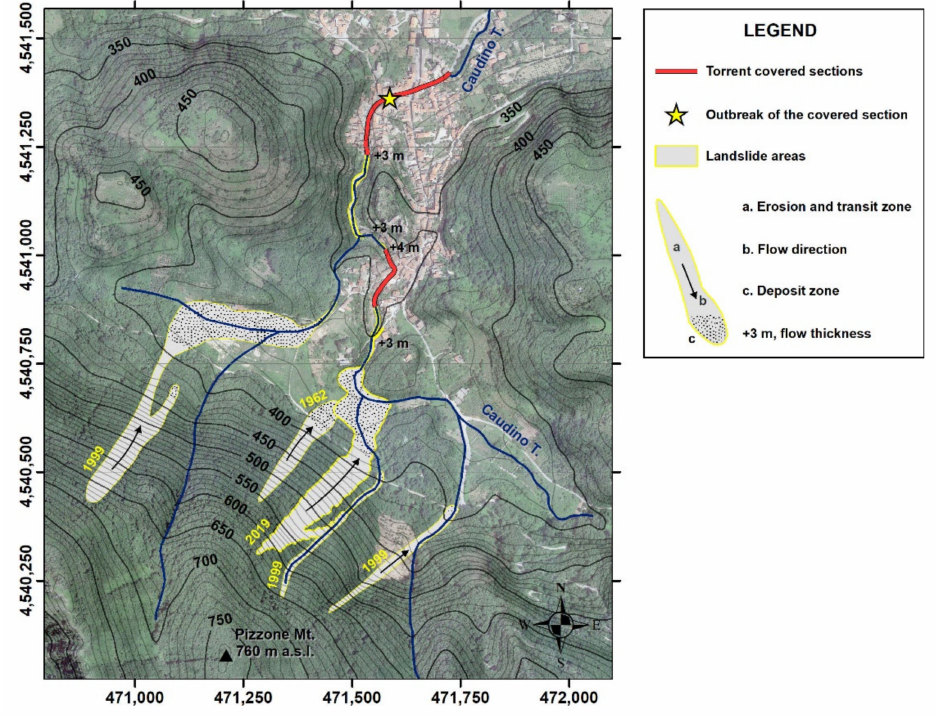
Figure 7. Landslides that occurred in San Martino V.C.; yellow number indicates the year of the event. Based on rainfall data recorded by more than 100 stations of the Campanian rain gauge network, the isohyet maps of the 16–20 December 1968, 14–16 December 1999 and 19–23 December 2019 rainstorms were made by using the kriging method and are